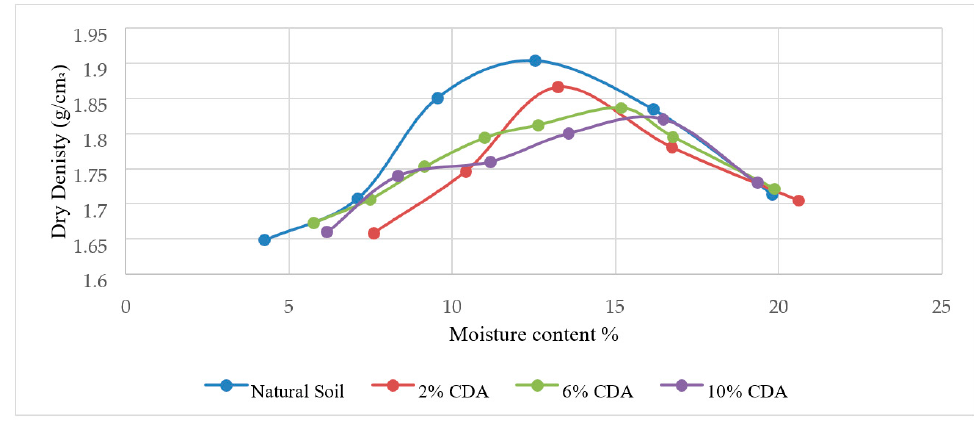
Figure 6. Cow dung ash Proctor results.